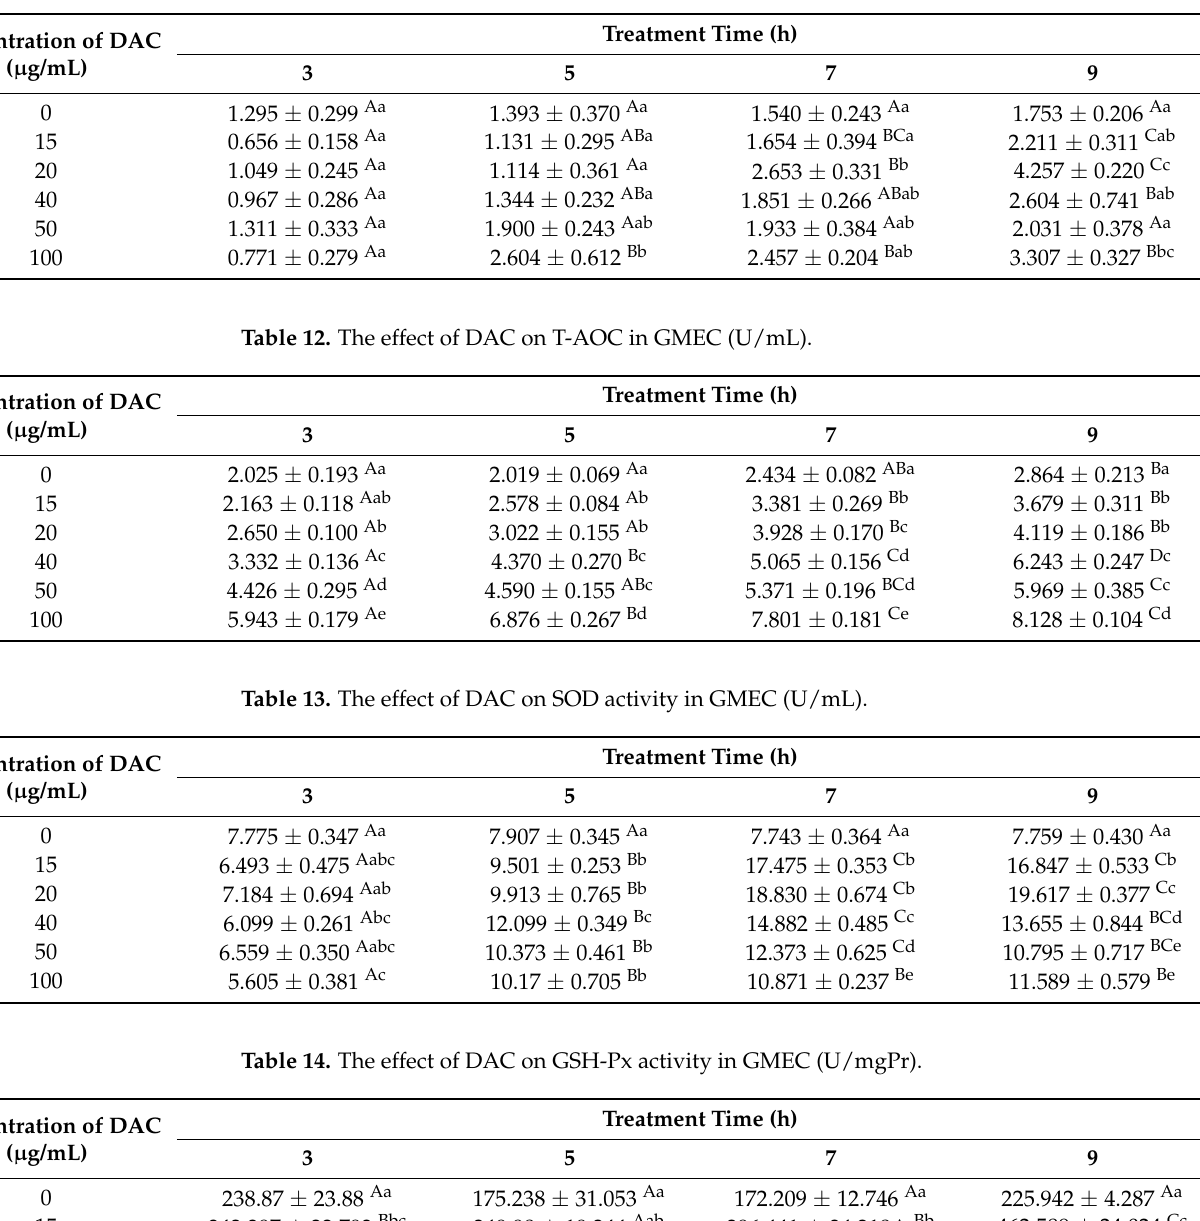
Table 11. The effect of DAC on CAT activity in GMEC (U/mL).